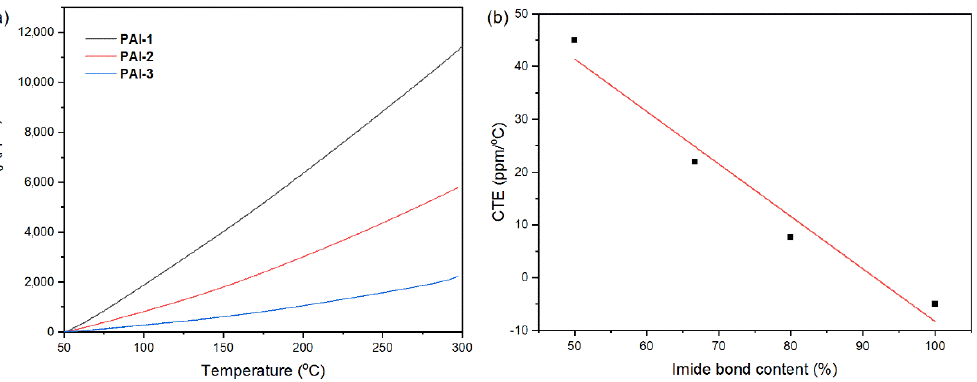
Figure 7. ( a ) TMA curves of the PAIs (3rd heating run, heating rate: 5 °C/min, in N 2 ). ( b ) The relation between imide bond content and CTE of the PAIs (CTE data of TFMB/PMDA homopolyimide taken from ref. [24]).